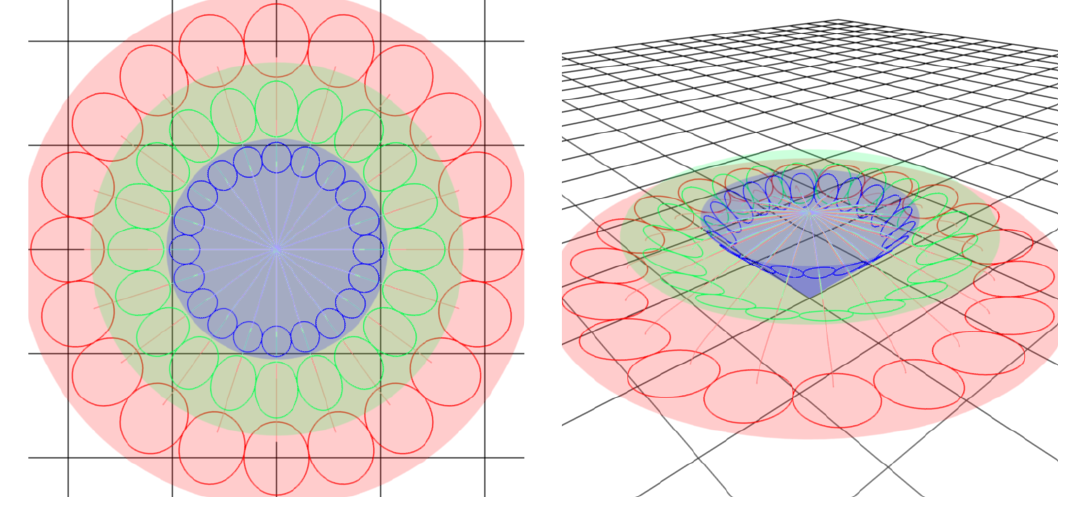
tangent ellipses. The virtual branches of the hyperbolae have one point of intersection at the apex S of the droplet (a): top view; (b): side